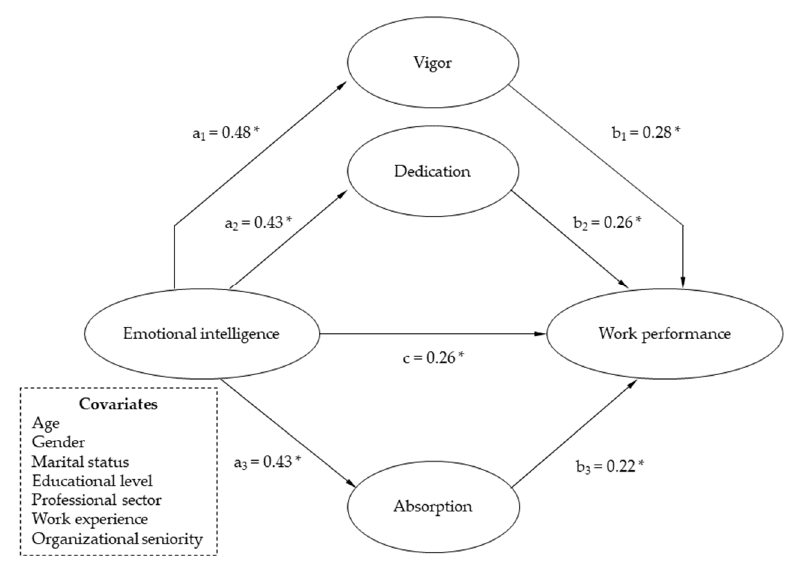
Figure 2. Multiple mediation model of the engagement dimensions acting between EI and WP. * p < 0.01.